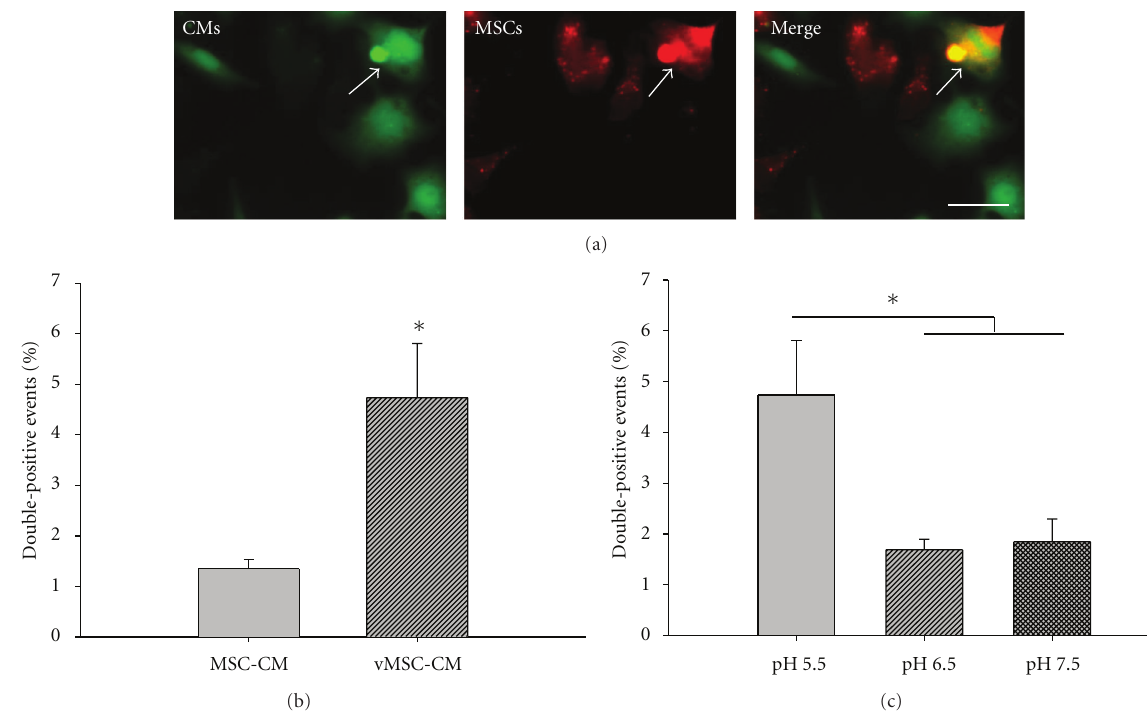
Figure 2: VSV-G facilitates vMSC-CM fusion. Four hours after pH-induced fusion, samples were harvested and analyzed using fluorescence deconvolution microscopy and flow cytometry for events displaying both CellTracker fluorescent probes. (a) Representative vMSC-CM fusion event (white arrow). CMs were labeled with CellTracker green and vMSCs were labeled with CellTracker red. Scale bar = 50 μ m. (b) E ff ect of VSV-G on vMSC-CM fusion at pH = 5.5. Fusion events were increased 3.5-fold with VSV-G at low pH. (c) E ff ect of pH on VSV-G-mediated MSC-CM fusion. vMSC-CM fusion was inhibited by pH = 6.5 and 7.5 (inactive form of VSV-G) ∗ P < 0 .